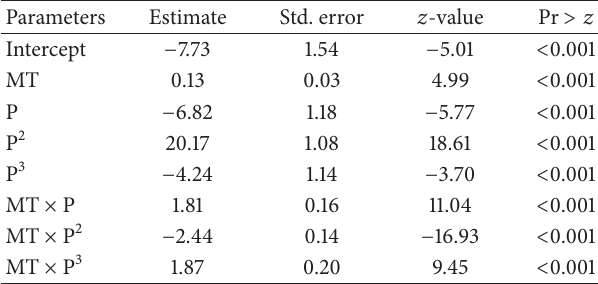
Table 4: Parameter estimates for the most supported model exploring effects of temperature and precipitation on the breeding migration pattern of T. cristatus .